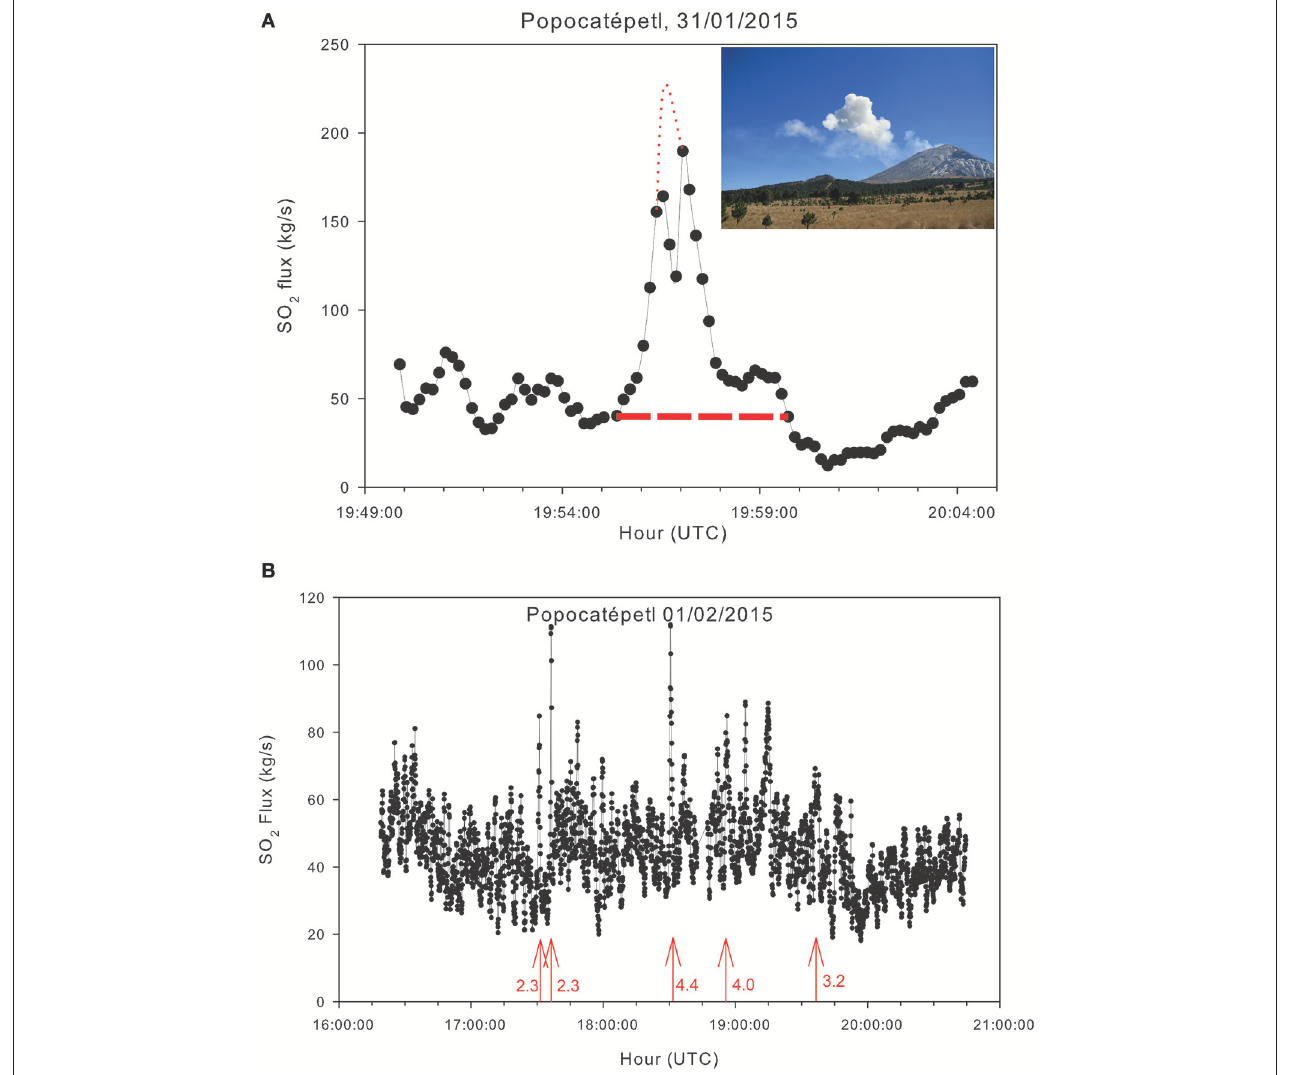
FIGURE 4 | (A) Typical SO 2 time series for an E1 type explosion, showing a sharp peak in midst of the normal degassing, followed by a rapid return to the pre-explosion values. The SO 2 mass (in tons) emitted by the explosion is calculated by integrating the curve above the background flux, highlighted by the thick dotted line. The presence of ash in the plume causes an underestimation of the real flux values, tentatively represented by the thin red line. (B) A 5 h long time series of SO2 fluxes on a day where E1 explosions (shown as red arrows) were occurring frequently. The mass released by each explosion is written next to its arrow, when it was possible to calculate